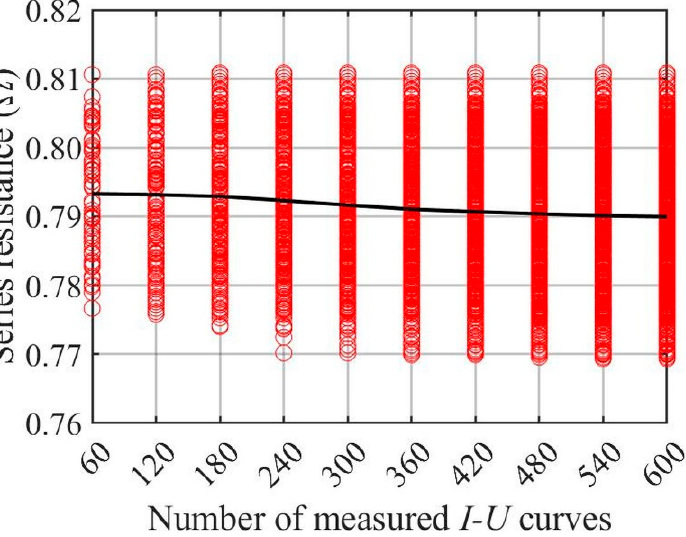
Figure 17. Fitted series resistance values (fitted to the entire I – U curves with 100 representative points) and their mean value as a function of the measurement period length starting from the curve at 1 s.